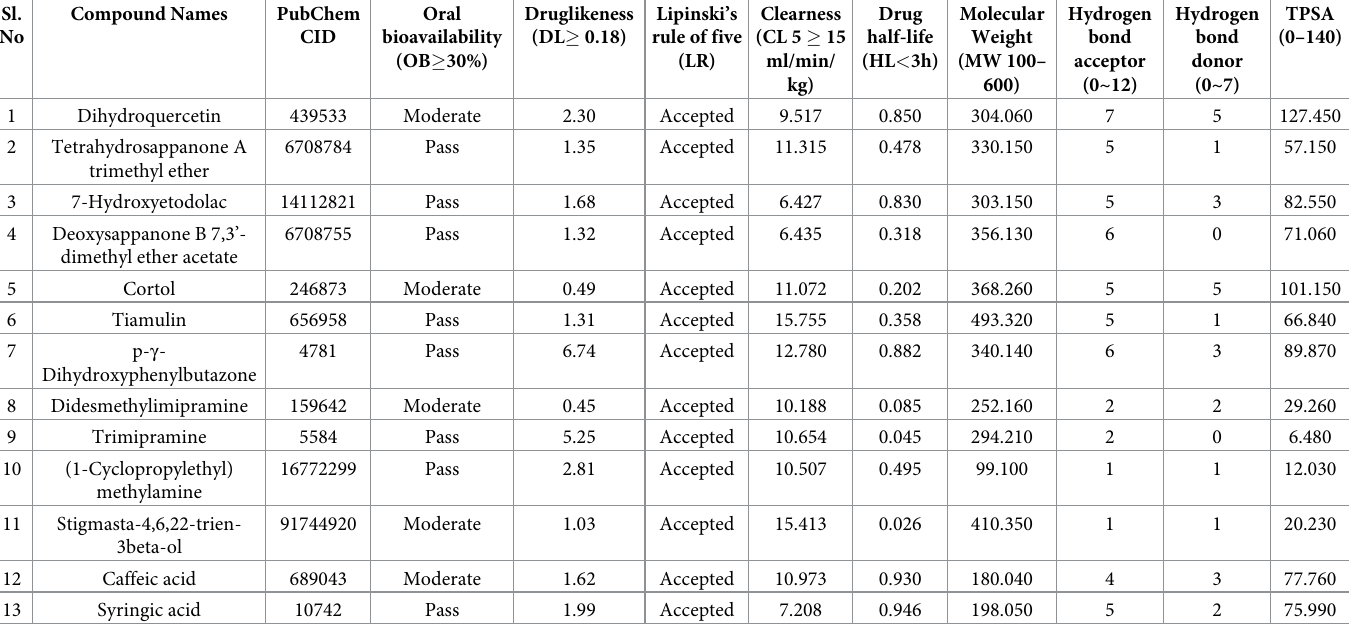
Table 1. Screening of active compounds using ADMET